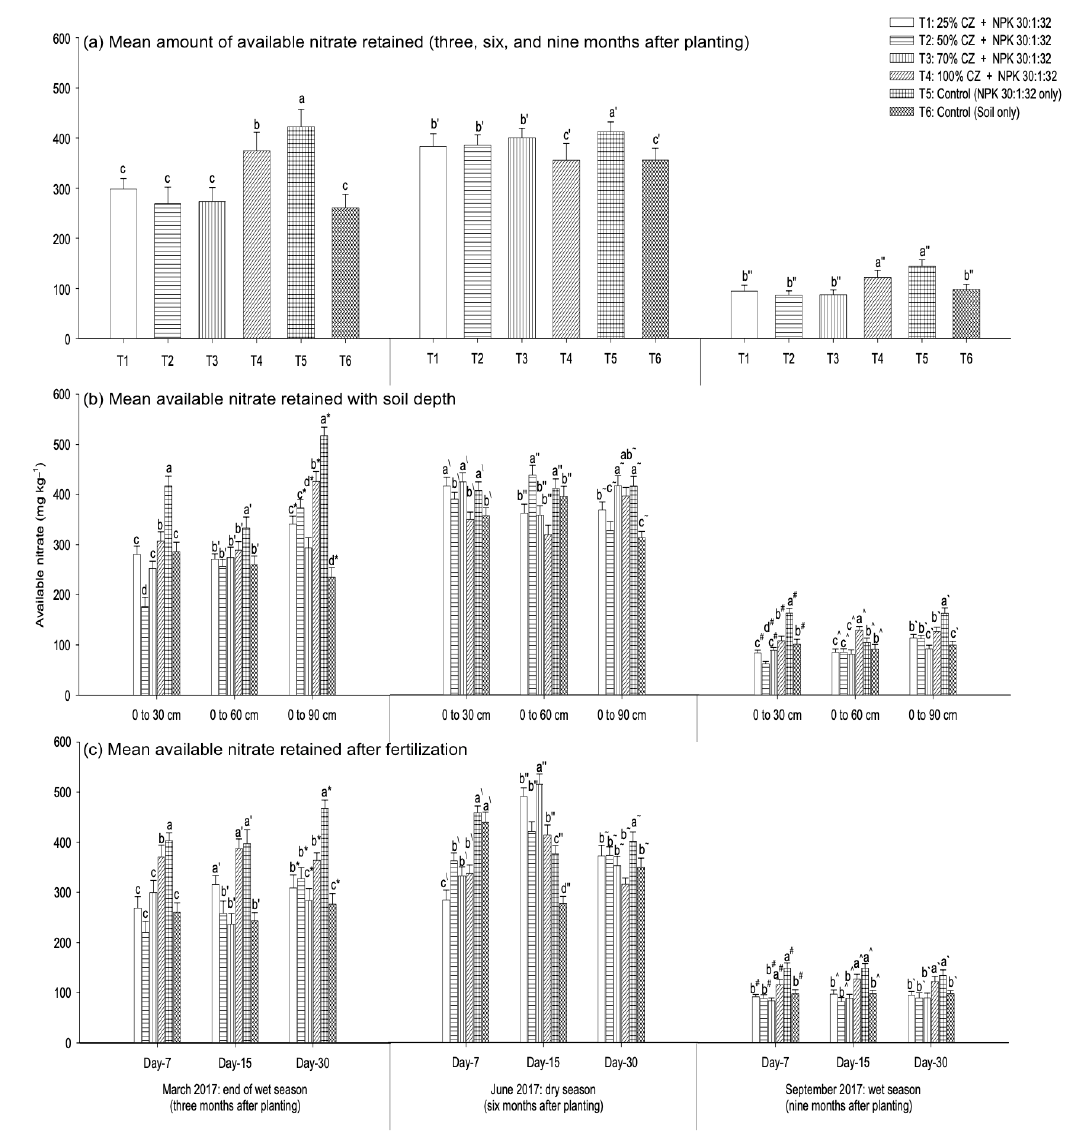
Figure 12. Effects of clinoptilolite zeolite on soil available nitrate retention at different vegetative stages (three, six, and nine months after planting): ( a ) mean amount of nitrate retained, ( b ) nitrate retention with soil depth (0 cm to 30 cm, 0 cm to 60 cm, and 0 cm to 90 cm), and ( c ) nitrate retention after fertilization (seven, fifteen, and thirty days) throughout the wet (March and September 2017) and dry (June 2017) seasons. Error bars indicate the standard error of the mean (n = 162). Means with different letters are significantly different using Tukey’s test with p ≤ 0.05. CZ: clinoptilolite zeolite. Letters without primes, single primes, and double primes represent mean nitrate retention respectively at three (March 2017), six (June 2017), and nine (September 2017) months after planting. Letters without primes, single primes, and asterisks represent nitrate retention at the end of the wet season (March 2017), letters with backslashes, double primes, and tildes represent the dry season (June 2017), and letters with hashes, carets, and backticks represent the wet season (September 2017).